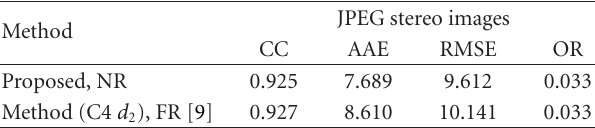
Table 8: Evaluation results of the comparison on IVC-IRCCYN laboratory’s